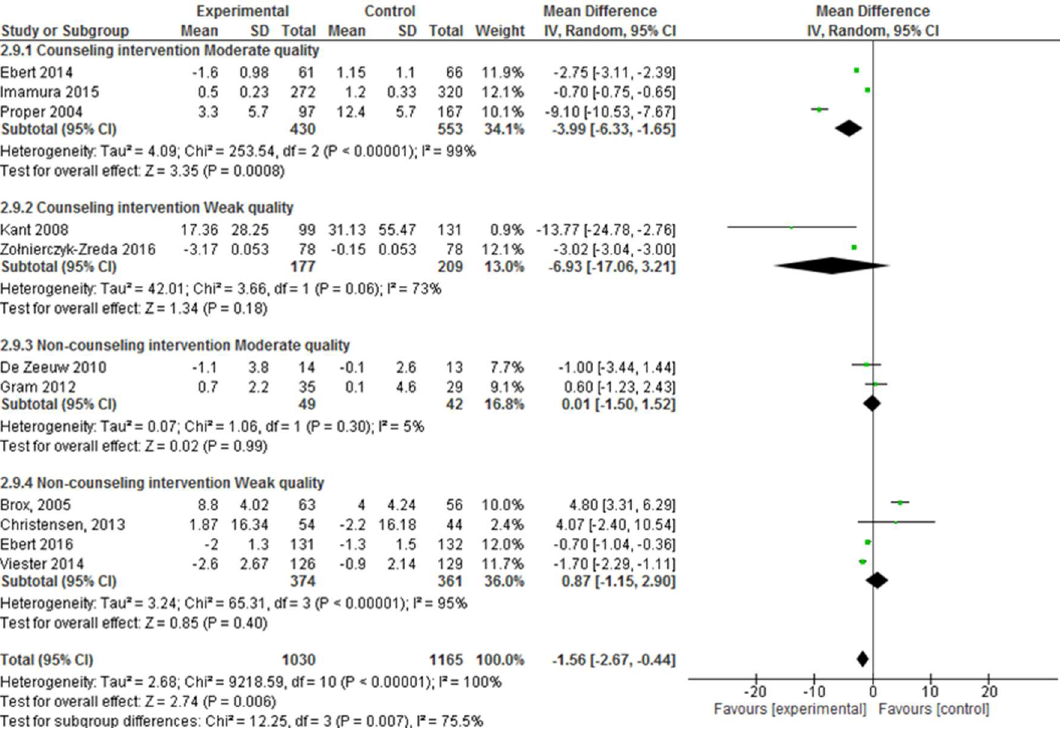
Figure 6. Forest plot of the effectiveness of counseling and non-counseling (multicomponent, physical activity and educational interventions) interventions for reducing absenteeism according to the quality of the studies.